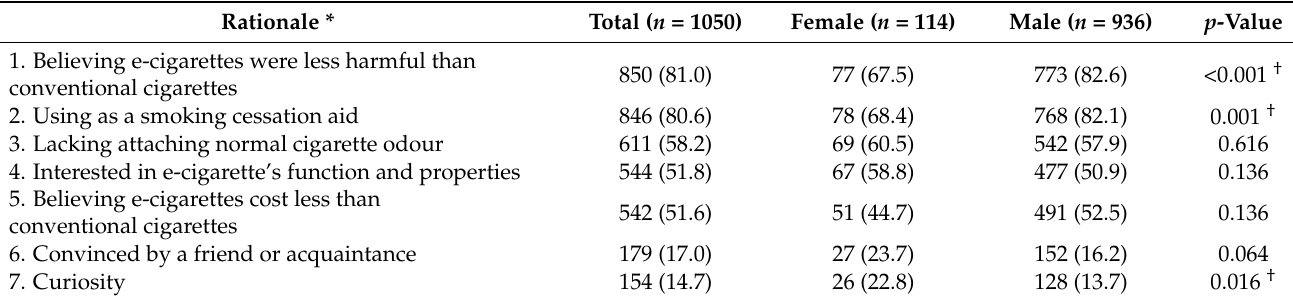
Table 3. Rationale of e-cigarettes users compared by sex ( n =